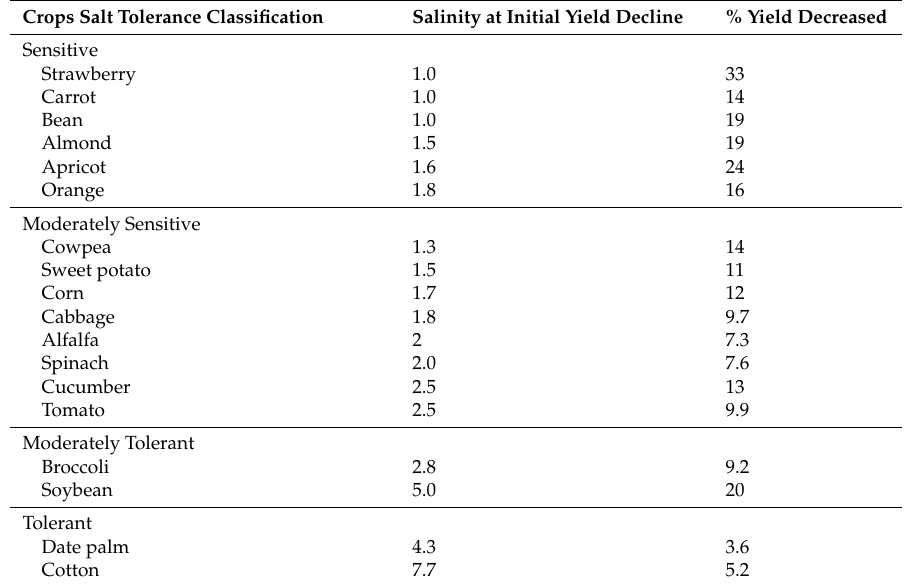
Table 6. Crop salt tolerance classification to irrigation water salinity (dS m − 1 ) and % yield decreased per unit of salinity increase in salinity beyond threshold. Data adapted from